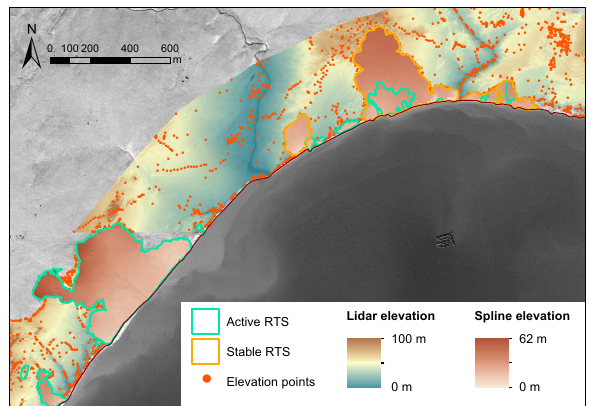
Figure 3. Map illustrating the different datasets used to model pre- slump topographies. Retrogressive thaw slumps (RTSs) are outlined in green for the active RTSs and orange for the stable RTSs.